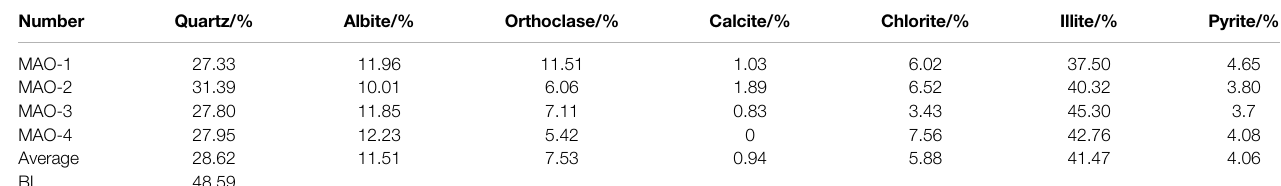
TABLE 2 | Mineral composition information of shale samples (BM-brittle materials).